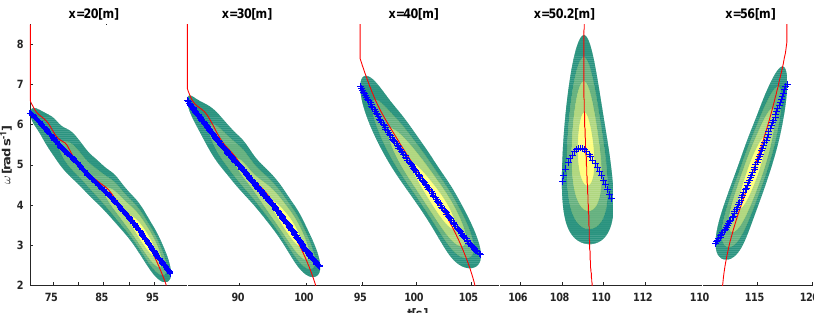
Figure 9. Case 202002. A filled contour plot of the energy distribution of the critical group event at position x = 20, 30, 40, 50.2, 56m. At each position, the red solid lines show the time of maximal energy at each wave frequency. The ++ lines show the wave frequency as function of time. Both are estimated by the most energetic waves in time and frequency, respectively. Before x = 50.2m, both solid and ++ lines show decreasing frequencies (increasing wave length) in time; then it leads to energy convergence.